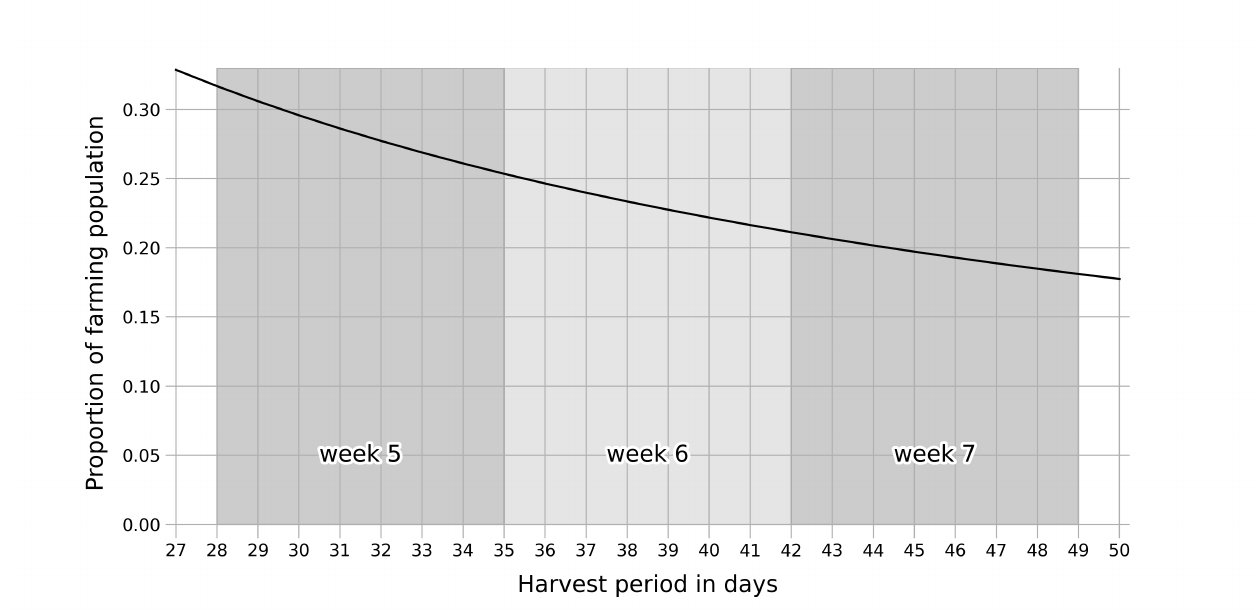
Figure 6. Proportion of the population that needs to be involved in the harvest of cereals and leguminosae within a given length of days. Considered harvest tasks are reaping, threshing, and